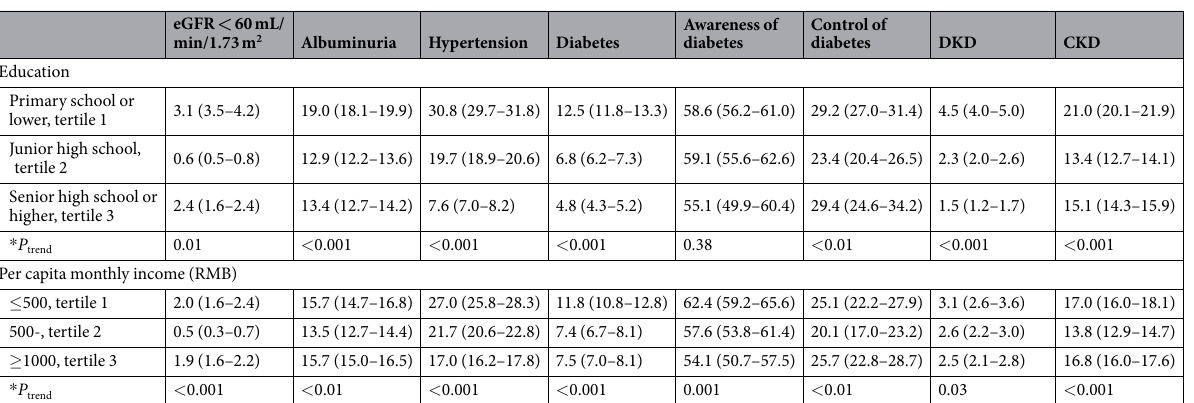
Table 5. Adjusted prevalence of indicators of renal damage by education and economic development. Note: Data were adjusted prevalence (%; 95% CI). Per capita monthly income was based on self-reported data. Abbreviations: eGFR, estimated glomerular filtration rate; DKD, diabetic kidney disease; CKD, chronic kidney disease. * P trend was calculated by Mantel-Haenszel chi-square